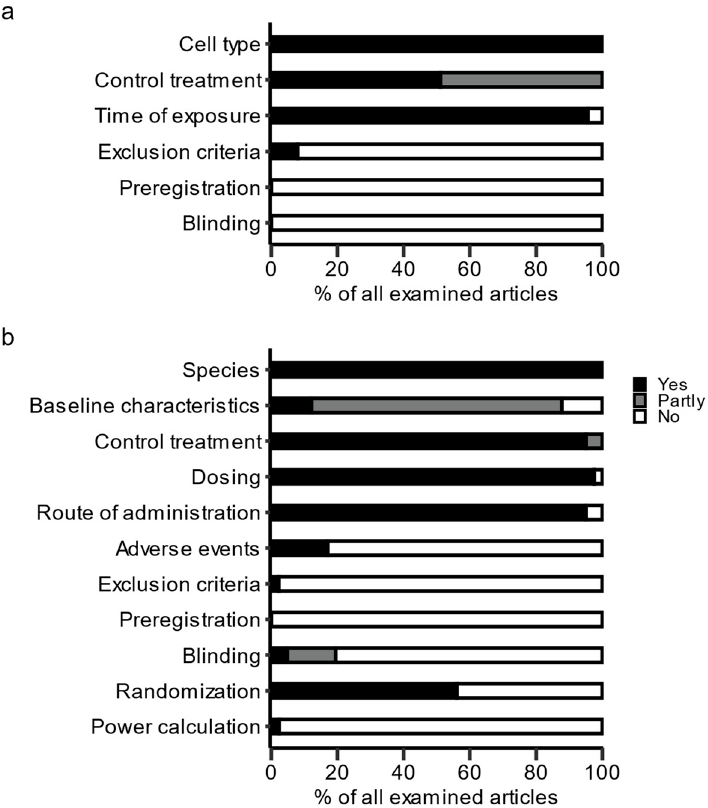
Figure 4. Methodological quality of original articles: ( a ) in vitro studies ( n = 50) and ( b ) in vivo studies ( n = 41). Depicted are percentages of articles reporting or applying the respective item.